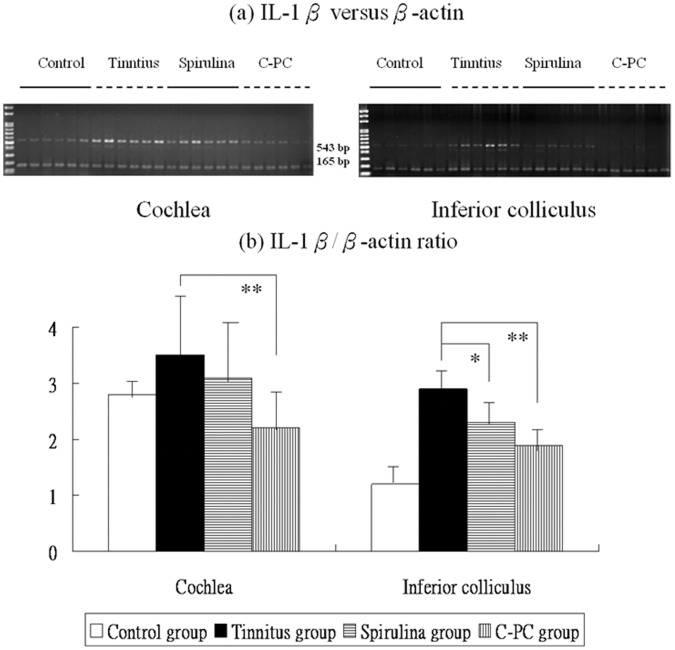
The levels of IL-1β mRNA expression in the four groups (a,b).There are significant differences in these levels among four groups. The IL-1β mRNA expression were significantly higher in the salicylate group than the control group. Compared to the tinnitus group, the Spirulina group (*) exhibits significantly reduced IL-1β mRNA level in the IC, whereas the C-PC group (**) exhibits significantly reduced IL-1β mRNA level in the cochlea and IC.